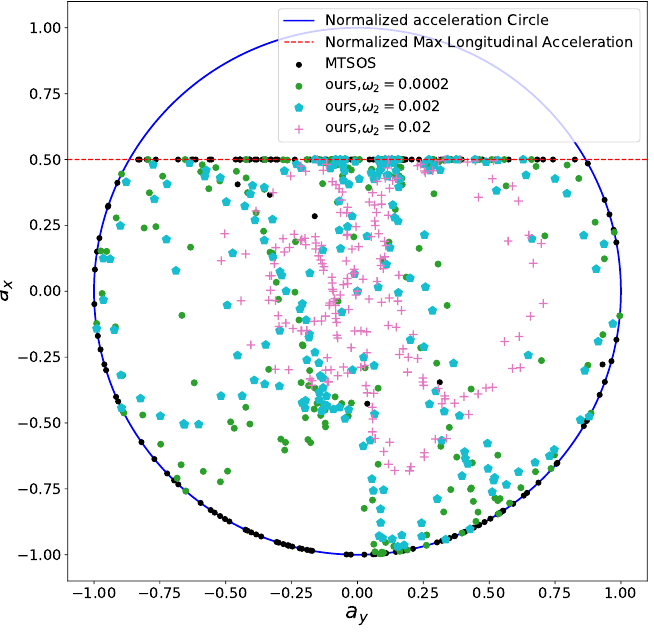
Figure 7. Friction circle for